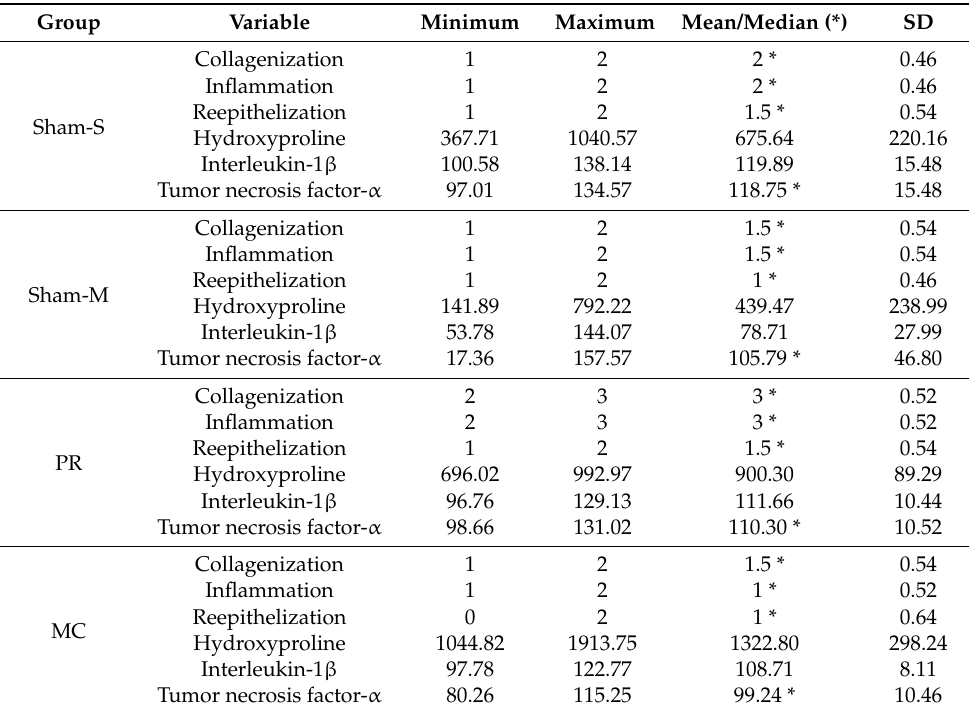
Table 2. Histopathological and biochemical results of all groups.